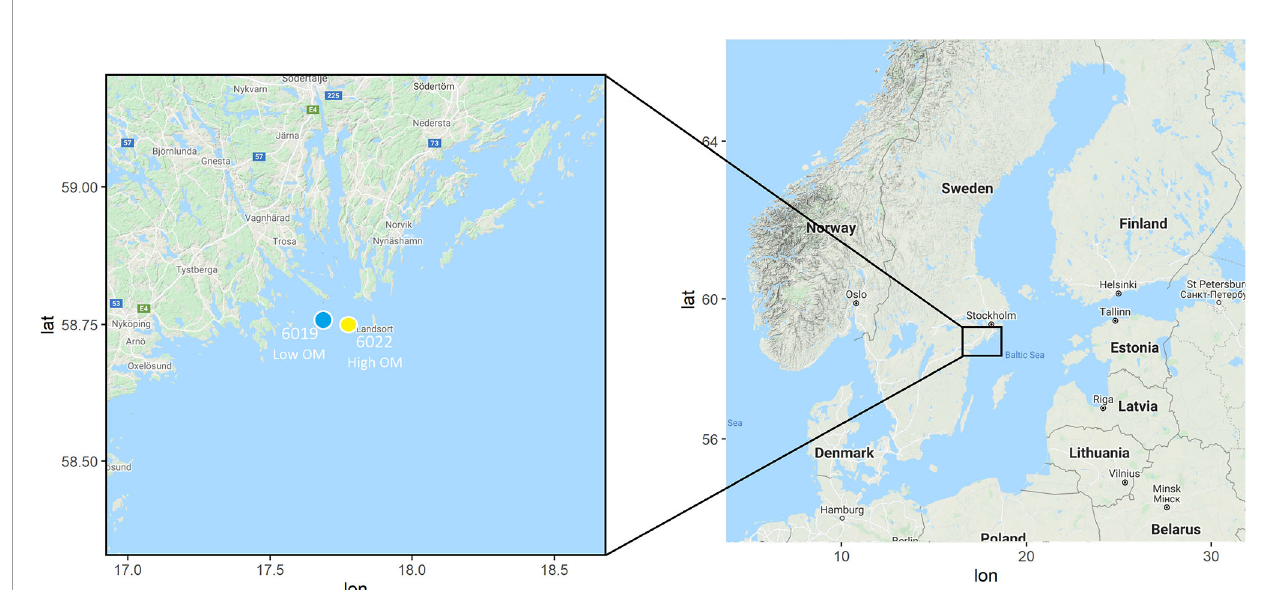
FIGURE 1 | Map of the stations used in this experiment, located along the Swedish coast in the Baltic Proper basin of the Baltic Sea, off the research station on the island of Askö. Station 6019 represents the low organic matter (OM) station (blue), and station 6022 represents the high OM station